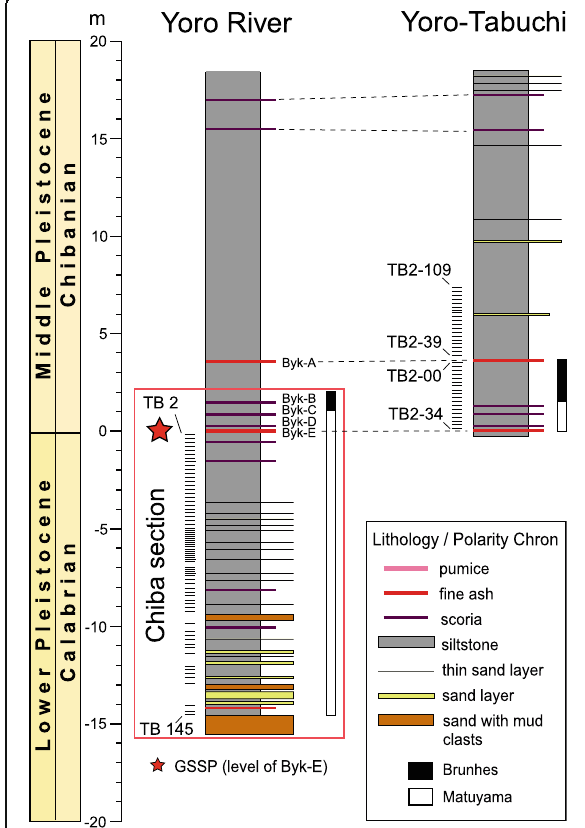
Fig. 3 Samples used in the present study. The lithology is from fig. 4 of Suganuma et al. (2018) and paleomagnetic polarity record from Okada et al. (2017) and Haneda et al. (2020a). The vertical scale (in m) represents stratigraphic distance from the Byk-E tephra bed. The GSSP is located at the base of the Byk-E tephra in the Chiba